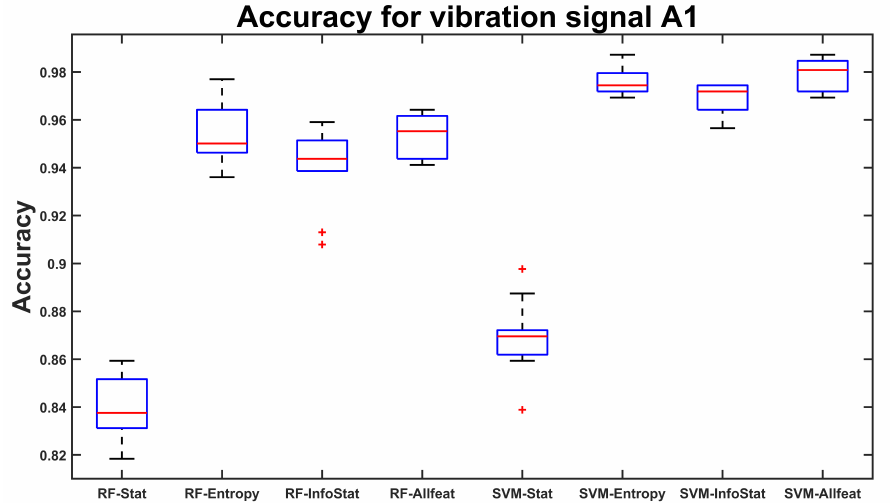
Figure 12. Comparison of accuracy for the machine learning models tested, considering several combinations of features extracted from channel A1 of the RC dataset. In the box plot, a red line represents the median of the data. The horizontal line over the box represents the upper quartile. The horizontal line below the box represents the lower quartile. The red cross, below or over the box, represents the